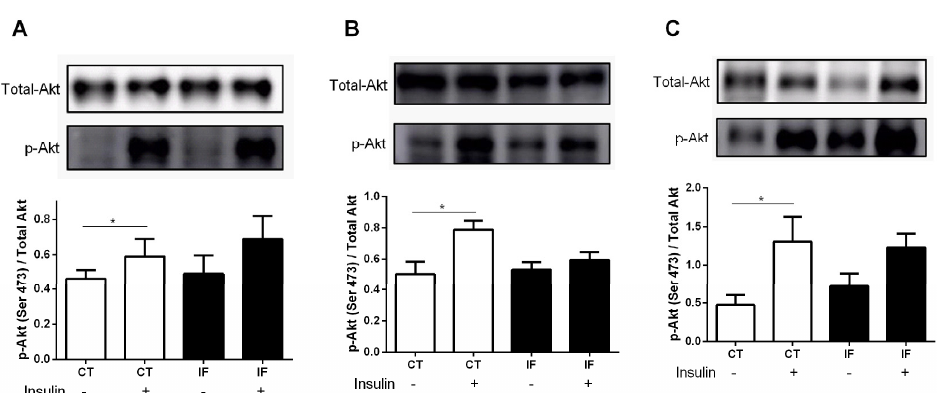
Figure 10. ( A ) Protein kinase B phosphorylation (p-AKT) expression of extensor digitorum longus (EDL) muscle, ( B ) liver, and ( C ) retroperitoneal white adipose tissue from Wistar rats submitted to IF for 12 weeks. The results are presented as the means ± standard error of the mean (SEM) with 5 different preparations for each group. * p <0.05 compared to the respective control, as indicated by Student’s t-test.